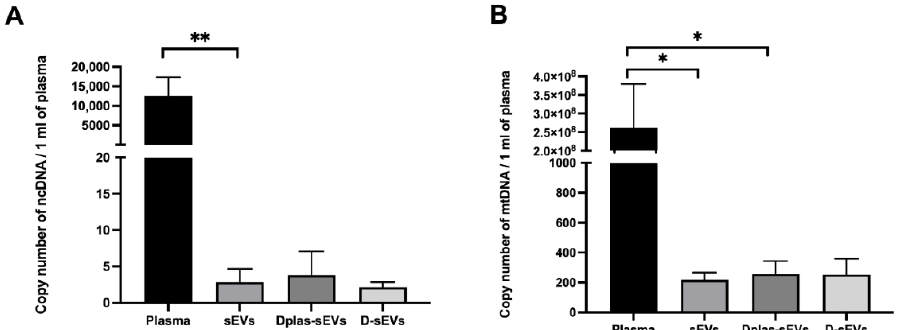
Figure 5. Number of DNA copies/mL of plasma in plasma and sEVs. ( A ) Nuclear DNA; ( B ) mito- chondrial DNA. sEVs – exosomes isolated from DNase non-treated plasma. Dplas-sEVs – sEVs iso- lated from DNase-treated plasma. D-sEVs – sEVs treated with DNase. * p ≤ 0.05; ** p < 0.01.